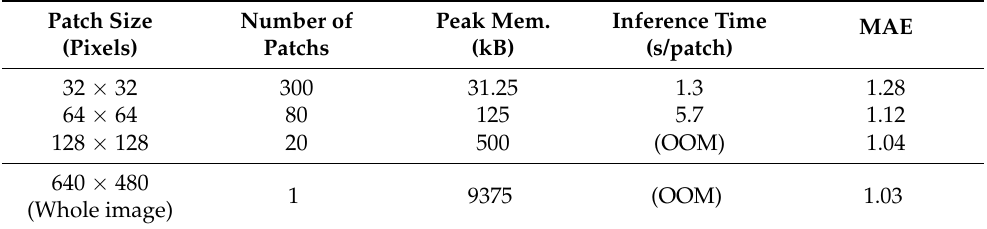
Table 3. Memory requirement and inference time of MiCrowdNet according to different patch sizes. OOM represents out-of-memory (MAE is still reported by calculating at the